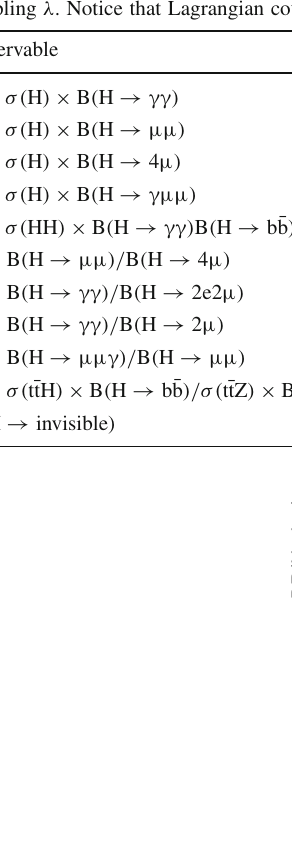
typically half that of what is shown here, since all rates and branching ratios depend quadratically on the couplings